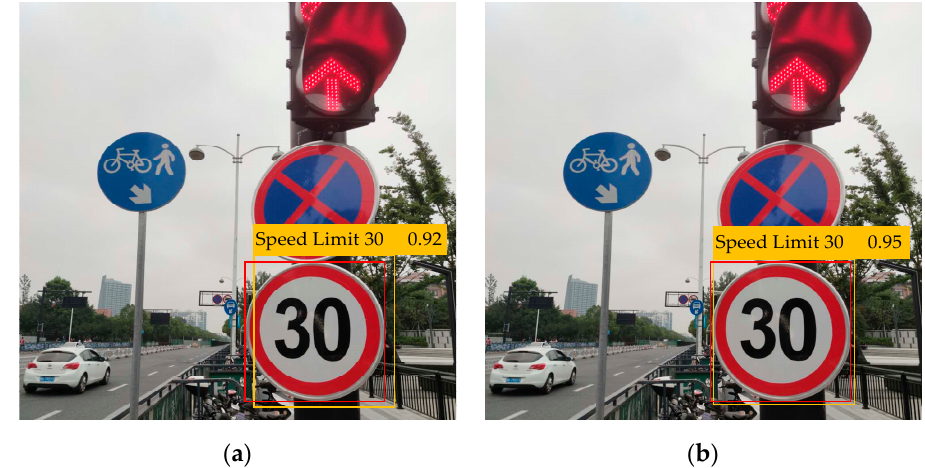
Figure 2. ( a ) is the recognition effect of baseline (K-means), and ( b ) is the recognition effect of the presented method (baseline + GMM). Notably, the ground-truth is labelled by red box, and the predicted one is marked orange. The baseline using the GMM clustering can acquire more accurate location information of the predicted bounding box and improve the recognition accuracy to some extent.